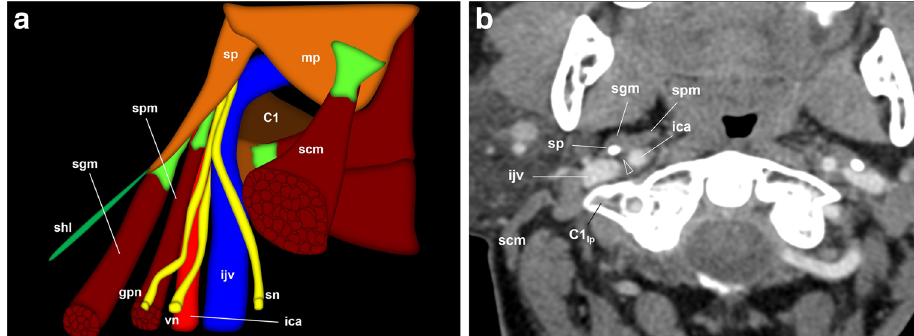
Fig. 8 The glossopharyngeal nerve (gpn), cervical portion. a Schematic drawing of the glossopharyngeal nerve when leaving the left jugular foramen. The glossopharyngeal nerve is located medial to the internal jugular vein (ijv) and behind the internal carotid artery (ica) in the carotid space. The styloid process (sp) is the most lateral reference at this point. At the level of the first cervical vertebra (C1), the glossopharyngeal nerve surrounds the artery laterally and descends between the styloid process and stylopharyngeus muscle (spm). scm: sternocleidomastoid muscle; sgm: styloglossus muscle; shl: stylohyoid ligament; mp: mastoid process: sn: spinal nerve; vn: vagus nerve.